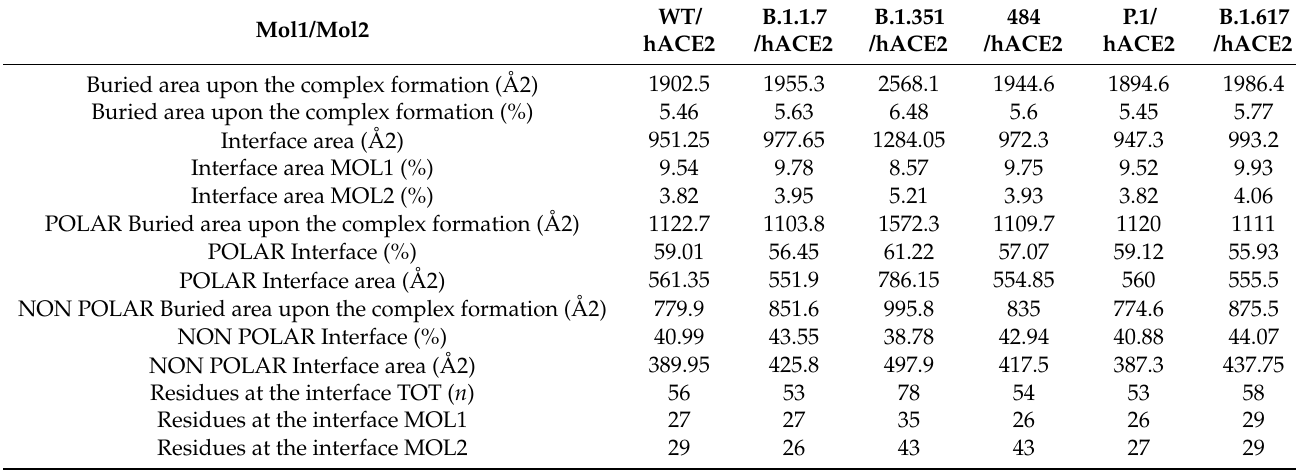
Table 3. The interaction features for the area of interfaces hACE2-spike